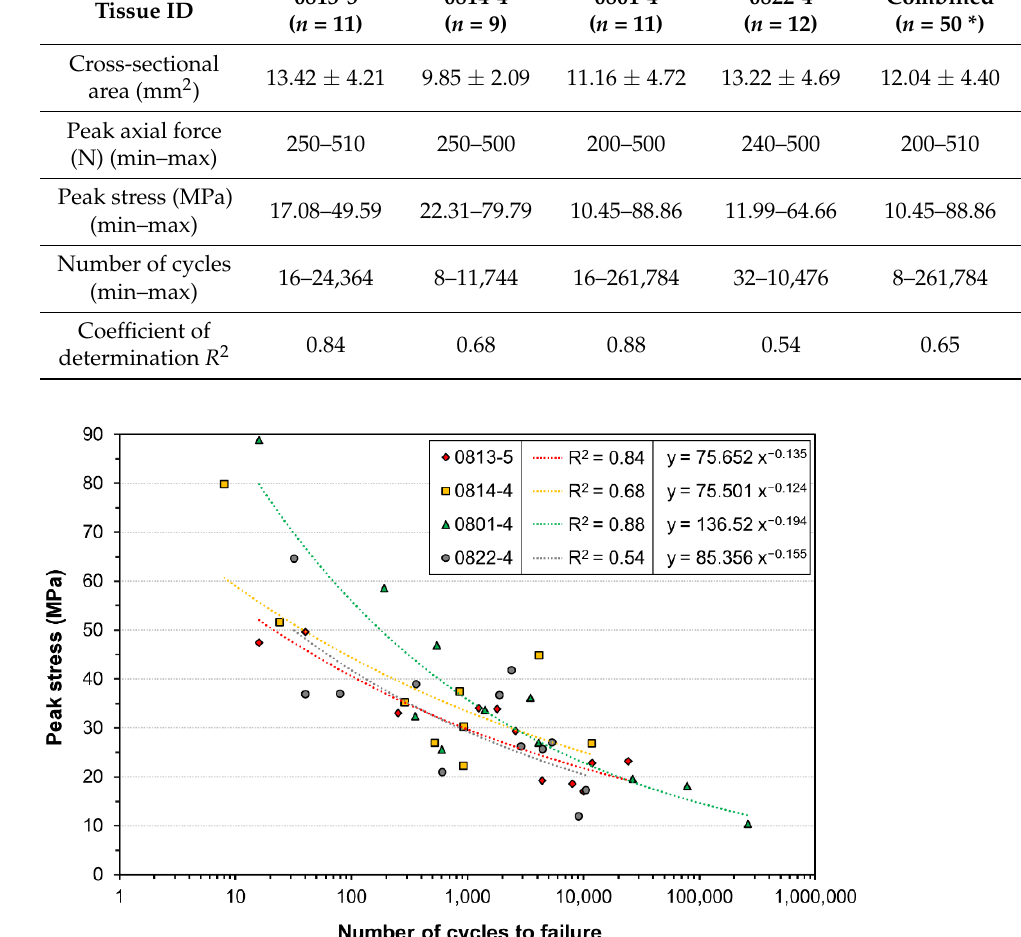
Figure 3. Subject-dependent S–N curves for tissues obtained from four donor cadavers. Each graph is approximated from the obtained data points using power regression.